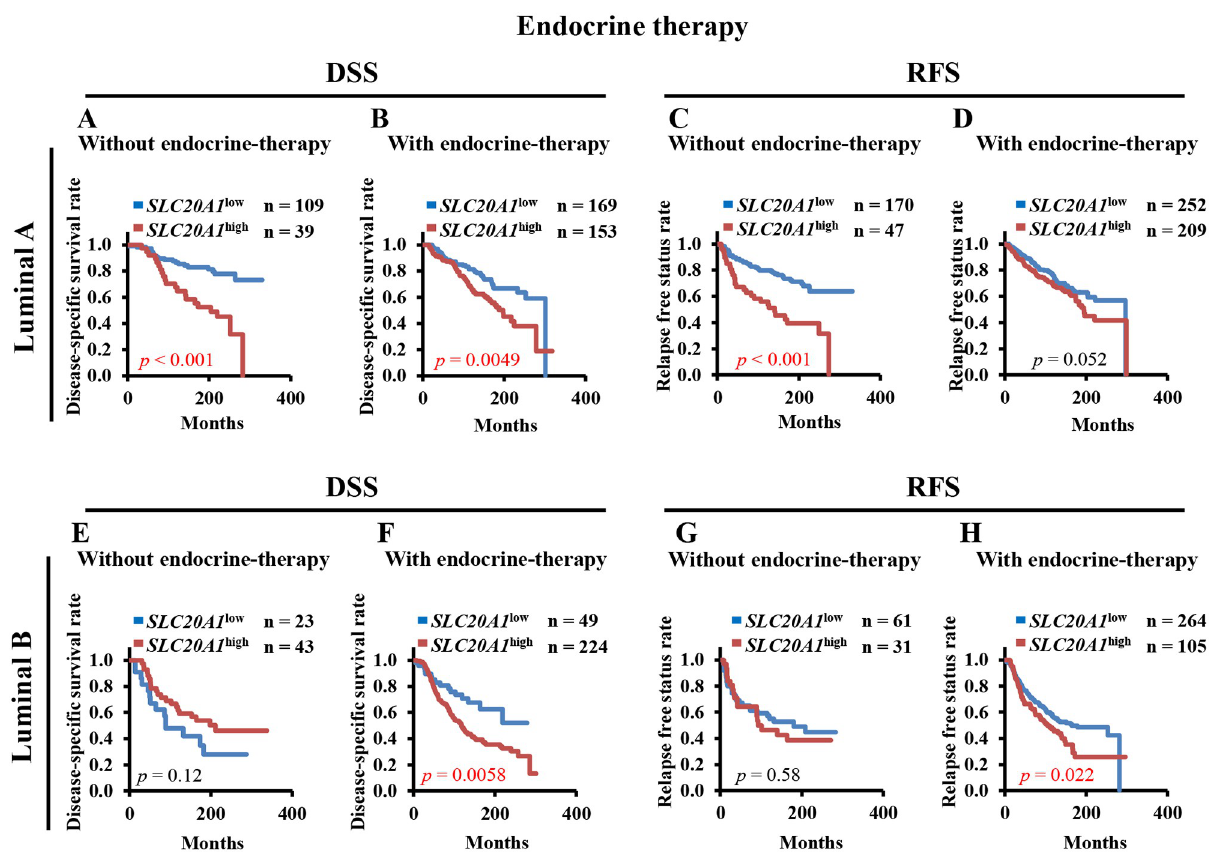
Fig 3. Higher solute carrier family 20 member 1 (SLC20A1) expression ( SLC20A1 high ) confer poorer clinical outcomes in the luminal A and luminal B breast cancer subtypes following endocrine therapy. (A-D) Kaplan-Meier analyses comparing disease-specific survival (DSS) and relapse- free status (RFS) between the SLC20A1 high and low SLC20A1 expression ( SLC20A1 low ) groups in patients with luminal A breast cancer without or with endocrine therapy. (A) DSS in the group without endocrine therapy. (B) DSS in the group with endocrine therapy. (C) RFS in the group without endocrine therapy. (D) RFS in the group with endocrine therapy. (E-H) Kaplan-Meier analyses comparing DSS and RFS between the SLC20A1 high and SLC20A1 low groups in patients with luminal B breast cancer without or with endocrine therapy. (E) DSS in the group without endocrine therapy. (F) DSS in the group with endocrine therapy. (G) RFS in the group without endocrine therapy. (H) RFS in the group with endocrine therapy.